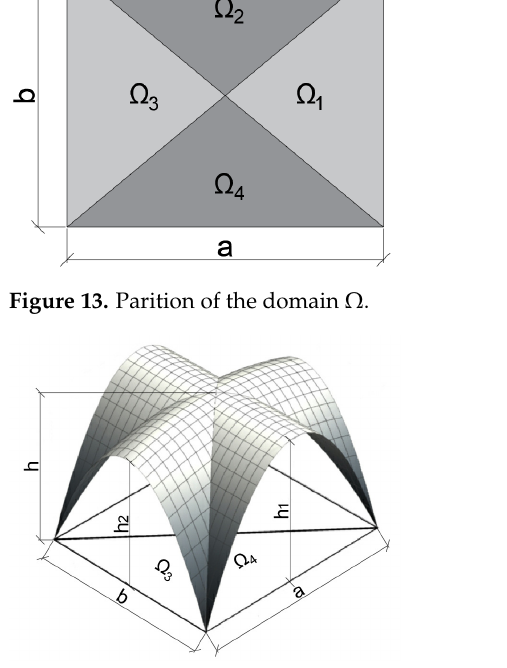
Figure 14. Perspective of the cross vault with main geometrical